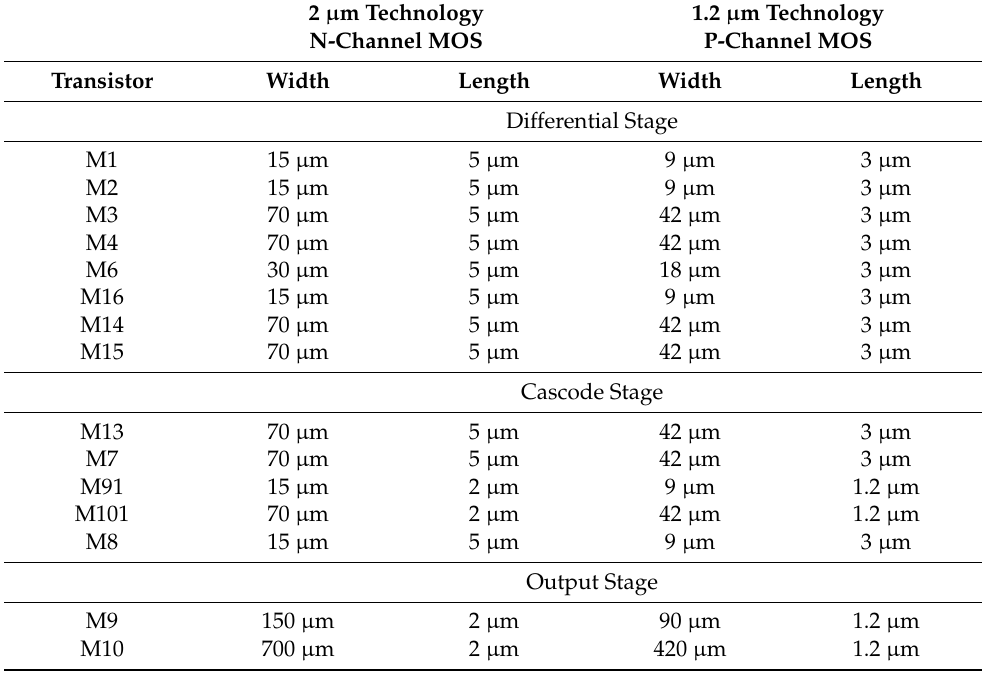
Table 4. Widths and lengths for N-channel and P-channel MOS transistors.